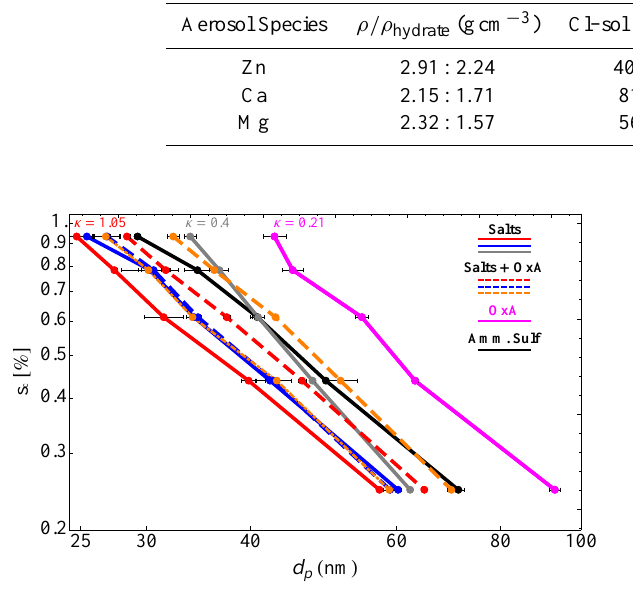
Figure 1. A schematic diagram of the experimental setup for CCN measurements. Fig. 1. A schematic diagram of the experimental setup for CCN measurements. figure Table 3. Solubilities (sol), intrinsic κ values ( κ intr ), and measured κ values ( κ meas ) for di-valent metal salts and their hydrates (Cl–Hyd). κ intr were calculated using Eq. (5) with densities from the CRC handbook.